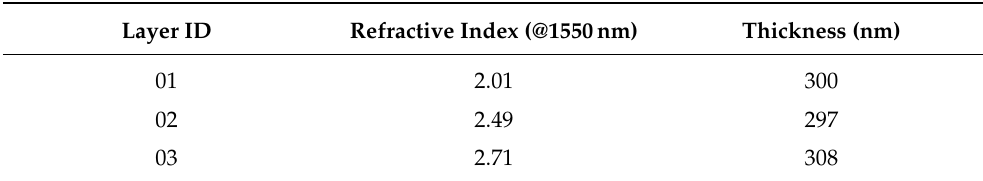
Table 3. Characteristics of the deposited Si-rich SiN layers used for the nonlinear performance study. Reproduced from [39] under a CC BY 4.0